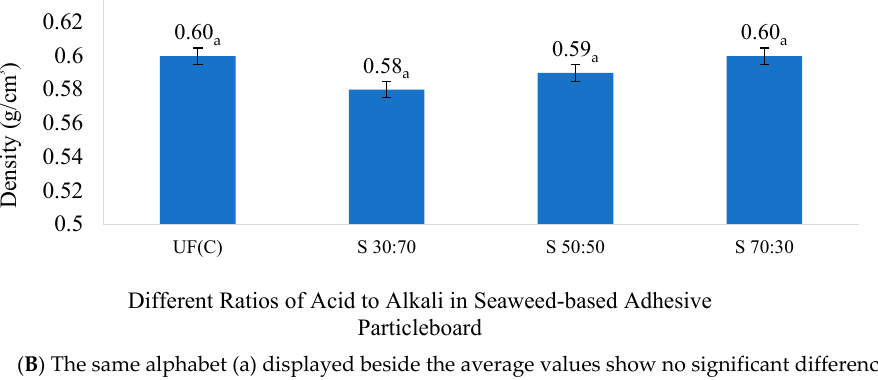
Figure 1. Average density values for ( A ) starch-based adhesive particleboard, ( B ) seaweed-based adhesive particleboard.